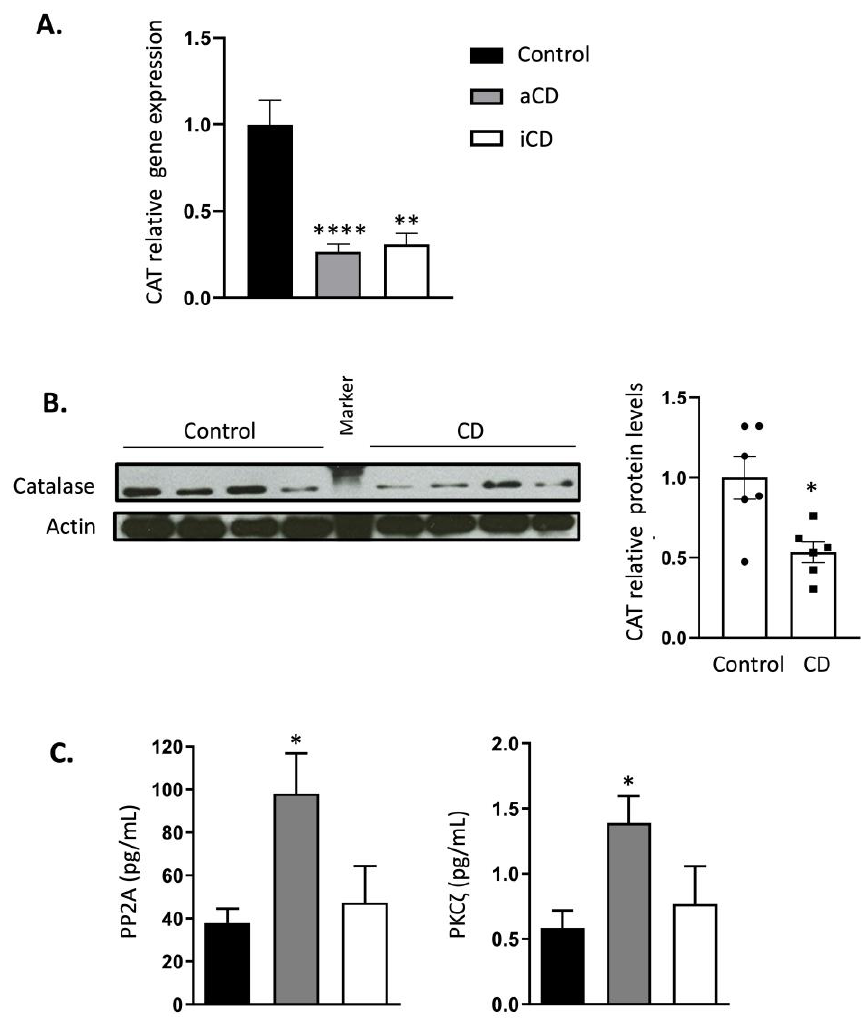
Figure 1. Permanent CAT inhibition in leukocytes isolated from Crohn’s disease (CD) patients. ( A ). Gene expression analysis of CAT in the controls and active and inactive CD patients ( N = 18, 20, and 10, respectively). ( B ). A Western blot densitometer, normalized with α -actin; its quantification represented in a histogram. The protein levels of CAT in the controls were significantly higher than in CD patients ( N = 6 and 6, respectively) normalized with α -actin. ( C ). The protein levels (pg/mL) of CAT regulators Protein Phosphatase 2A (PP2A) and Protein Kinase C zeta (PKC ζ ) in the controls; active and inactive CD patients ( N = 7, 10, and 4, respectively). The levels of both regulators had increased more in CD than in the control and iCD patients. The results are shown as mean ± SEM. The differences between the controls and both the active and inactive CD patients (aCD and iCD, respectively) were assessed by Student’s t -test. * p < 0.05, ** p < 0.01, **** p < 0.0001.